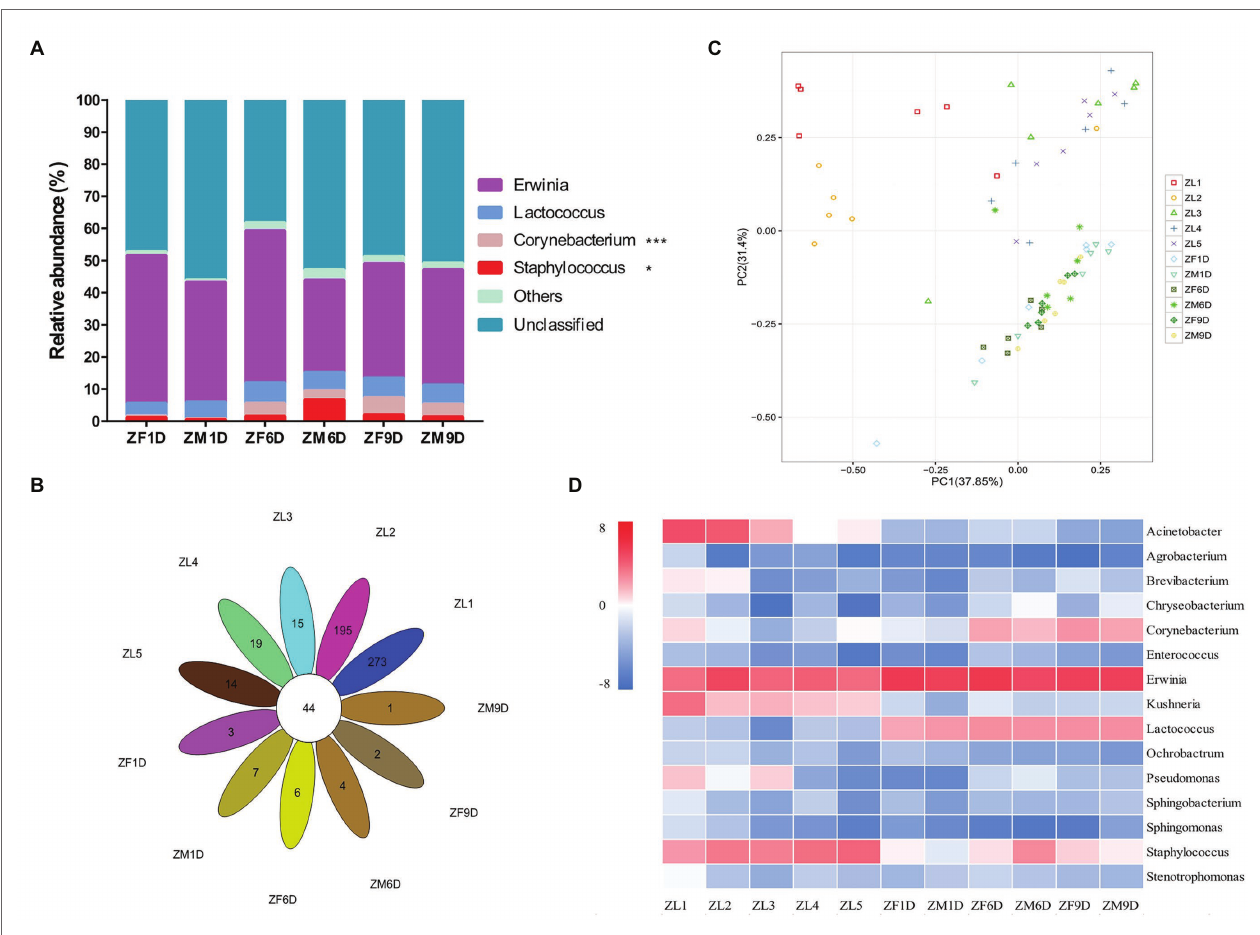
FIGURE 2 | Bacterial community dynamics among different developmental stages in A. suturalis . (A) Relative abundance of bacteria communities at the genus level in adult stages. (B) Core-Pan OTU presents the common and unique OTU of all samples in petal diagram. (C) Difference of OTU types in different developmental stages based on Principal Components Analysis (PCA). (D) Heat map analysis of the top 15 microbial populations with relative abundance at different developmental stages. The data represented by color in the figure is represented by log2(relative abundance). Bacteria with relative abundance lower than 0.5% in all samples were all merged into others (Kruskal-Wallis test, *0.01 < p ≤ 0.05 and *** p ≤